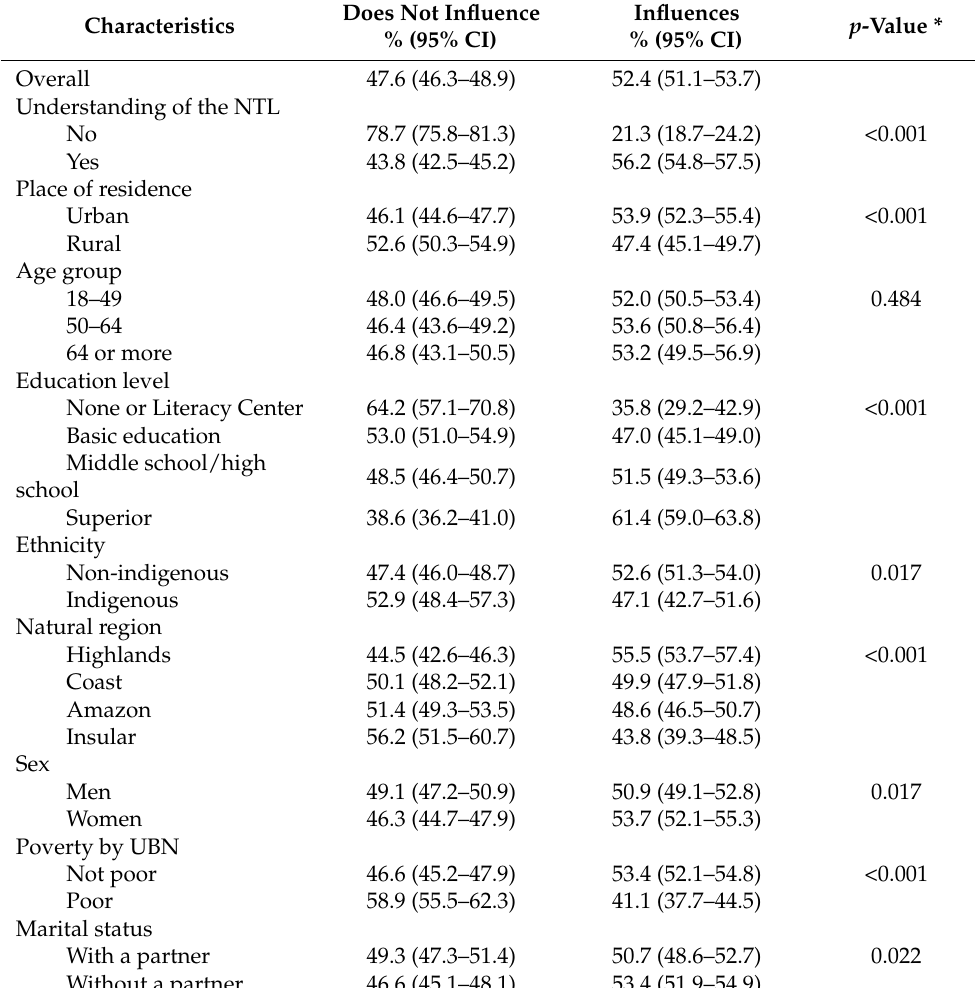
Table 2. Characteristics associated with the influence of the nutritional traffic light on the decision to purchase processed foods in the adult population of Ecuador,